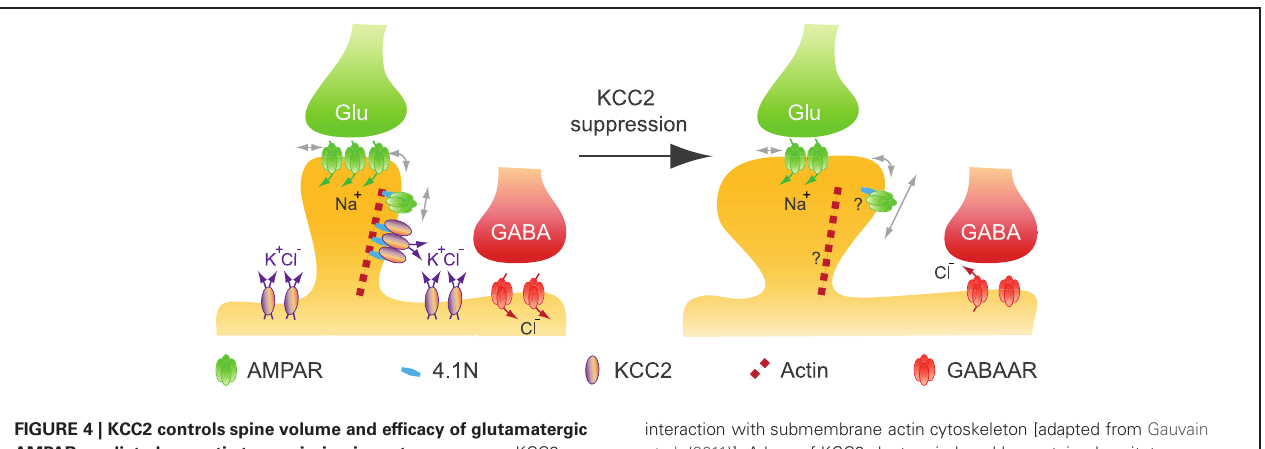
FIGURE 4 | KCC2 controls spine volume and efficacy of glutamatergic AMPAR-mediated synaptic transmission in mature neurons. KCC2 suppression in mature neurons indicates that KCC2 is not required for spine maintenance, while it contributes to both spine head volume regulation and the efficacy of excitatory synapses by physically constraining AMPAR GluA1 subunit in spine head, likely through its